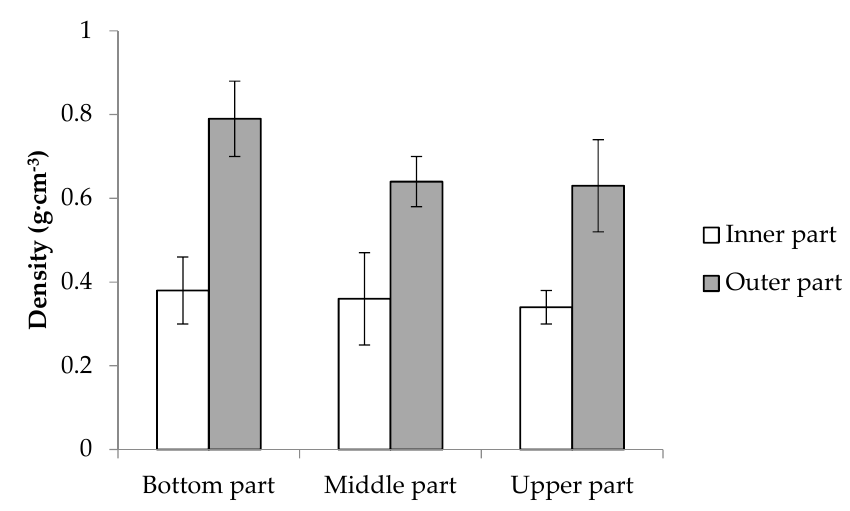
Figure 3. Density of unsmoked samples.